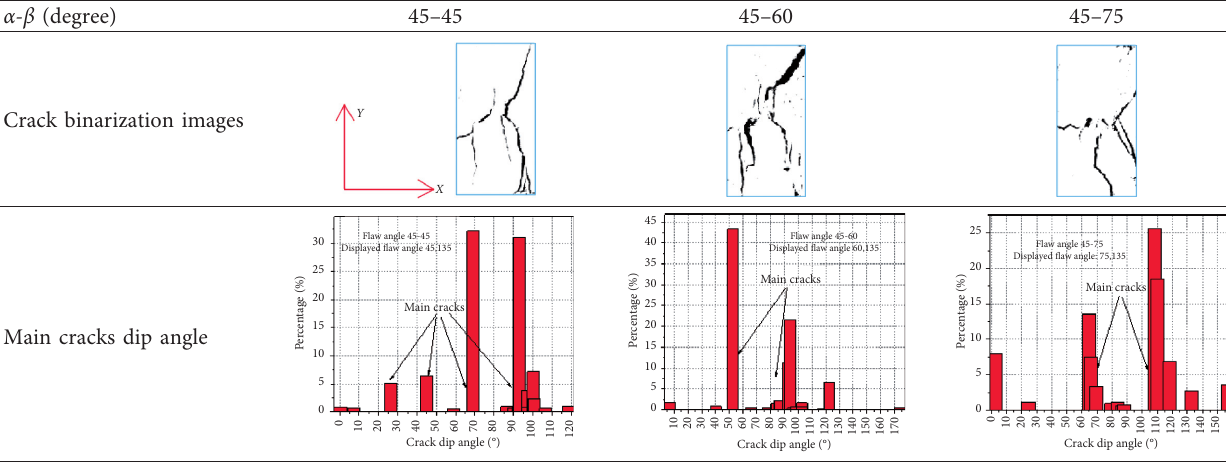
Table 7: Crack binarization images and the distribution of main cracks dip angle in ultimate failure modes of the specimens containing two parallelogram flaws at α � β � 60 ° , α � 60 < β � 75 ° , and α � β � 75 ° under uniaxial compression. α - β (degree)